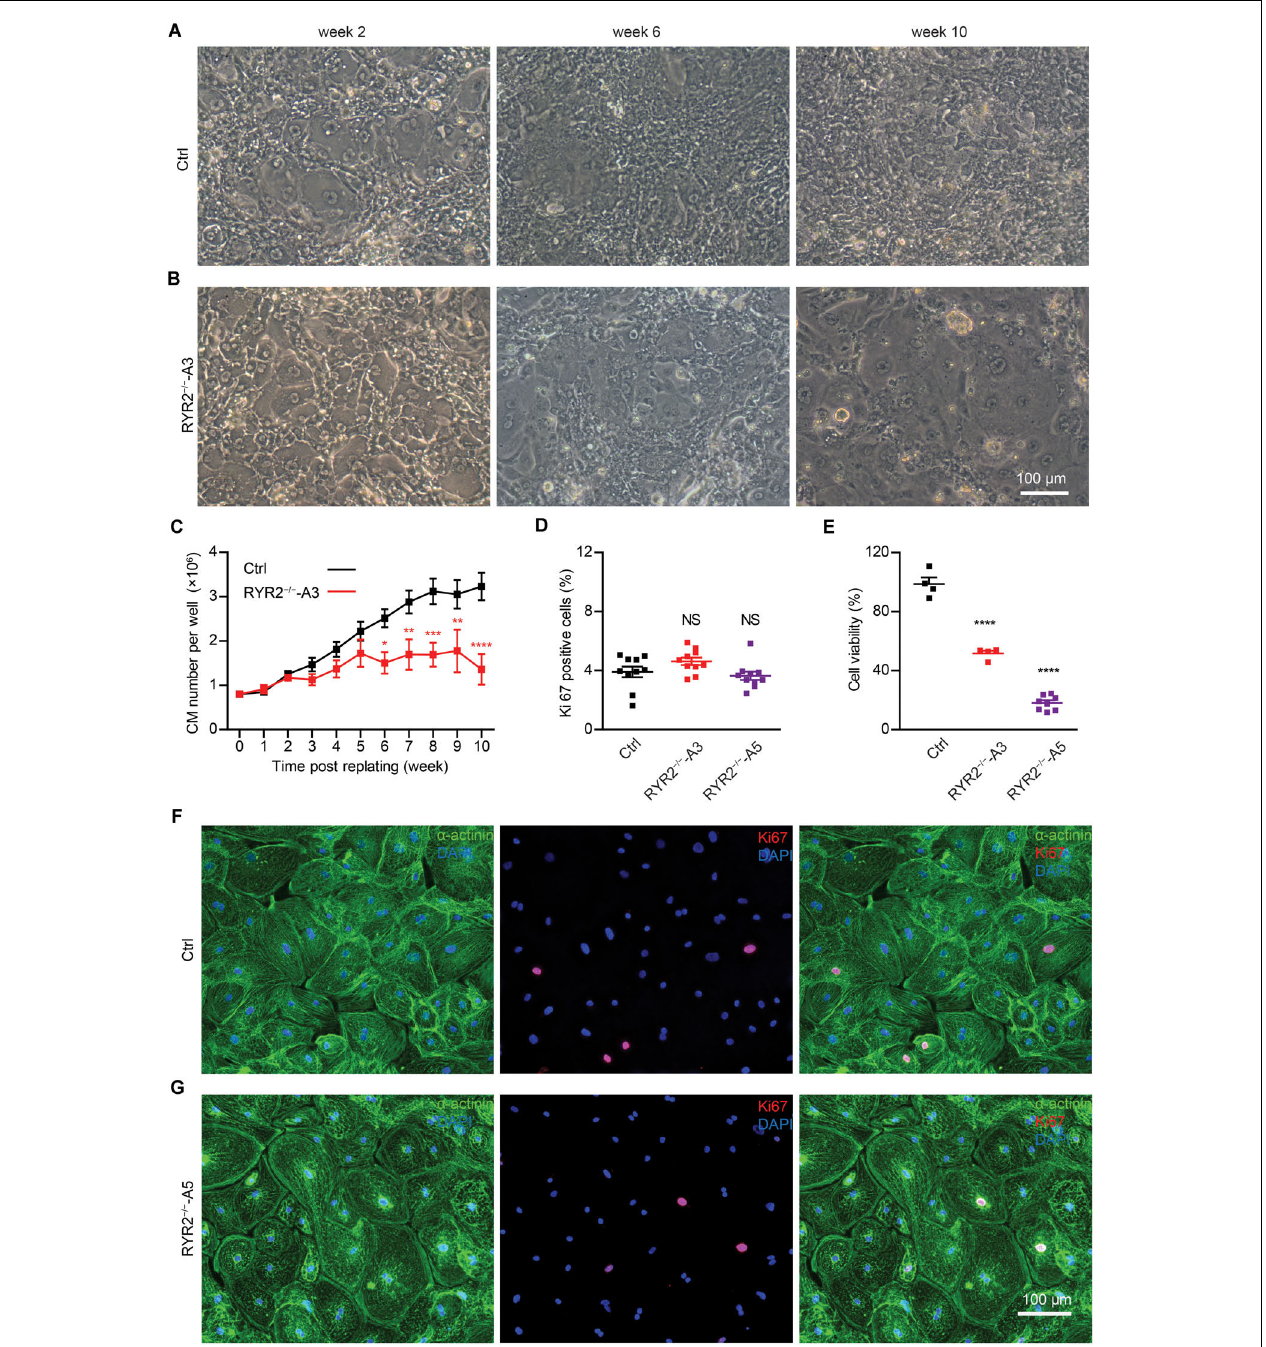
FIGURE 2 | Growth analysis of Ctrl- and RYR2 − / − -iPSC-CMs during long-term culture. (A,B) Bright-field images of Ctrl-iPSC-CMs (A) and A3 RYR2 − / − -iPSC-CMs (B) after replating at day 20 of differentiation. Ctrl-iPSC-CMs showed an increase in cell density from week 2 to week 10 post replating (A) , while RYR2 − / − -iPSC-CMs exhibited reduced cell density (B) . Scale bar, 100 µ m. (C) Quantification of the cardiomyocyte numbers. Ctrl- and A3 RYR2 − / − -iPSC-CMs showed distinct growth curves during long-term cell culture. Ctrl-CMs from 2 different iPSC lines and 11 differentiation experiments (iBM76.1: n = 6 and iWTD2.1: n = 5) were analyzed. A3 RYR2 − / − -CMs from six differentiation experiments were used. * P < 0.05, ** P < 0.01, *** P < 0.001, and **** P < 0.0001, RYR2 − / − vs. Ctrl by using the two-way ANOVA with the Sidak’s multiple comparison test. (D) Percentage of Ki67-positive CMs ( n = 10 samples each for Ctrl, A3 and A5, n = 300–400 cells per sample counted). (E) Cell viability of Ctrl-, A3 and A5 RYR2 − / − -iPSC-CMs (Ctrl: n = 4 from two differentiation experiments; A3 RYR2 − / − : n = 4 from two differentiation experiments; A5 RYR2 − / − : n = 8 from two differentiation experiments). **** P < 0.0001 by using the one-way ANOVA with the Dunnett’s multiple comparison test (D,E) . (F,G) Representative immunostaining of Ctrl- and RYR2 − / − -iPSC-CMs probing for Ki67 (red) and α -actinin (green). Cells were counterstained with DAPI (blue) to show the nucleus. Scale bar, 100 µ